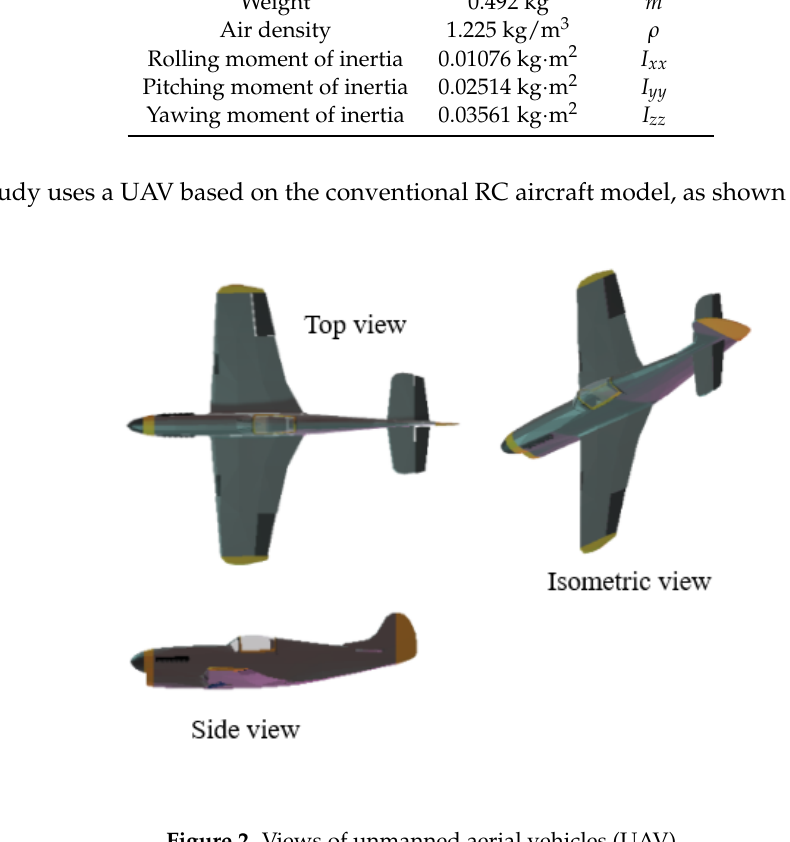
Figure 2. Views of unmanned aerial vehicles